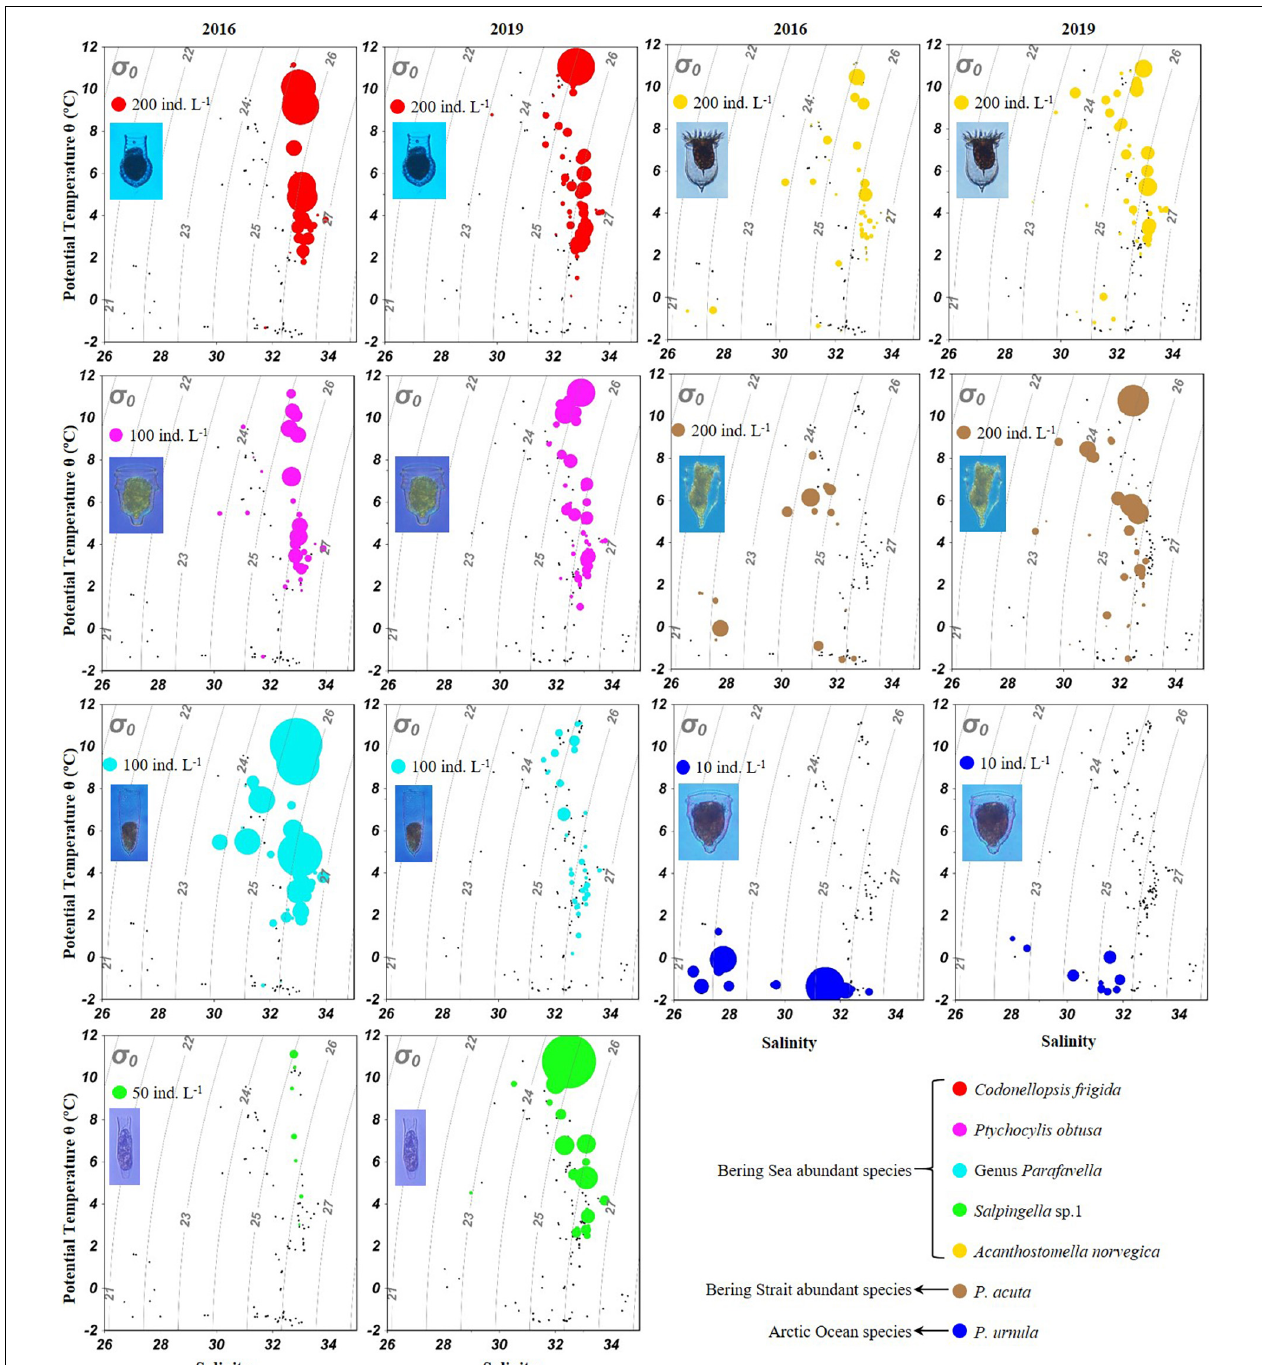
FIGURE 7 | Temperature-salinity-plankton diagrams for abundant oceanic tintinnids in 2016 and